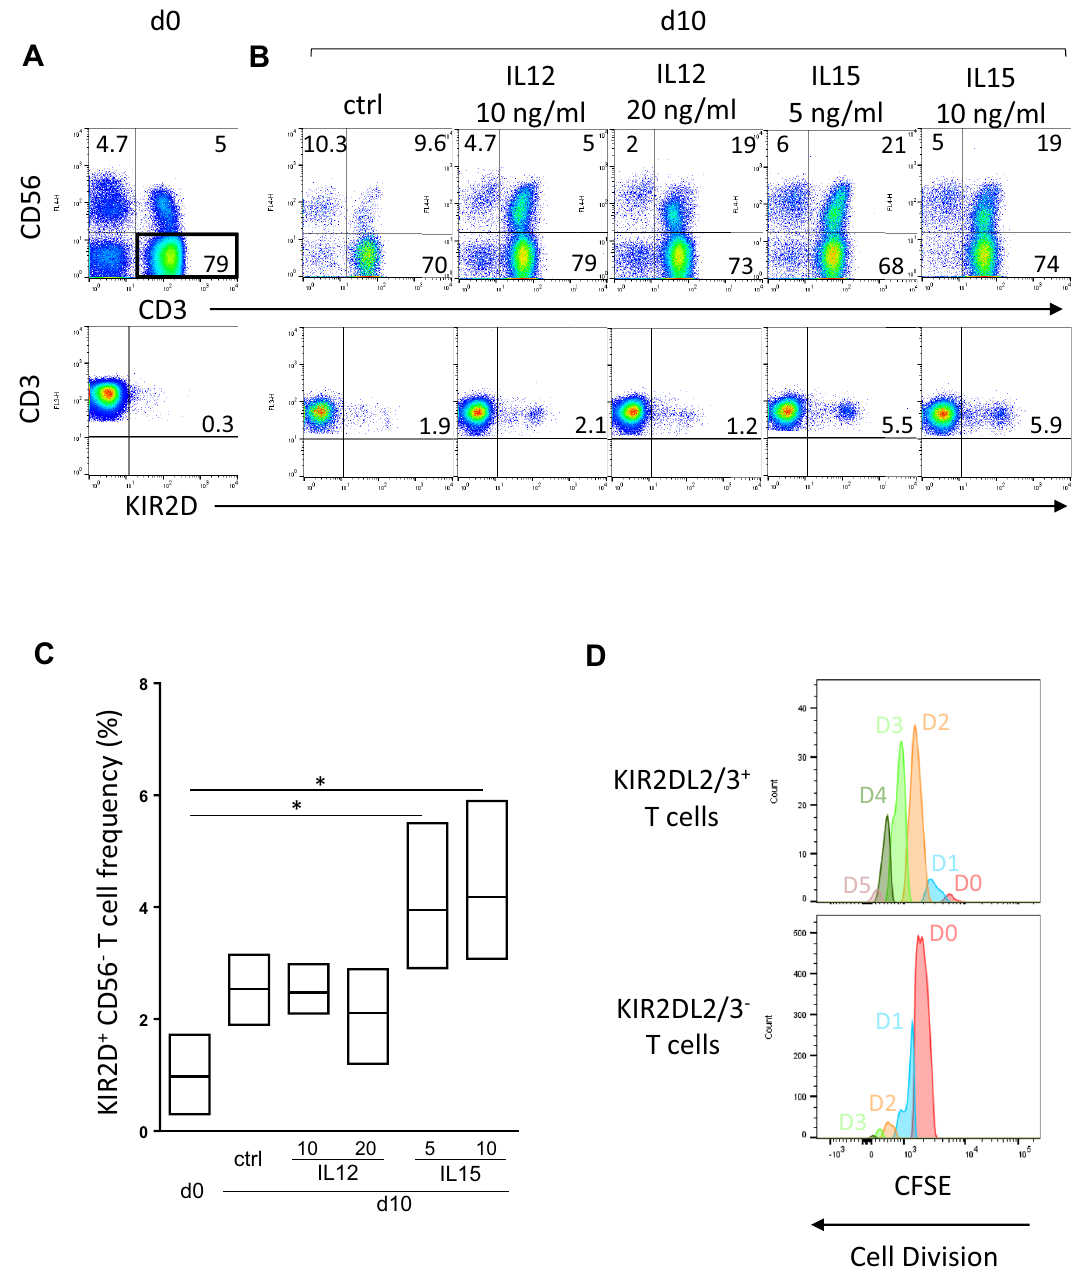
Figure 2. IL-15 stimulates KIR + lymphocyte expansion. (A) Representative density plots illustrating KIR2DL1/2/3/2DS1/2 expression on CD56 − T cell subsets targeted using CD3 and CD56 combination at day 0 by flow cytometry (B) and day 10 after PBMC culture with IL-2 at 50 U/ml alone or in combination with IL-12 (10 and 20 ng/ml) or IL-15 (5 and 10 ng/ml). The cell frequency is indicated on all density plots. (C) Floating bars (min to max) compiling results of different experiments realized from 3 healthy blood donors. *Indicates p < 0.05, ANOVA. (D) Representative histograms of KIR − and KIR + T cell proliferation by the method of CFSE that allows the identification of dividing cells stimulated for 6 days with 10 ng/ml IL-15. Generation’s gates are indicated (DO to